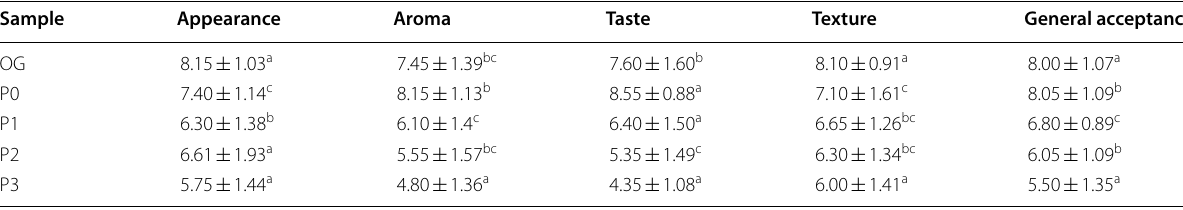
Values are mean of thirty panelists standard deviation ( n 30). Values with the different superscript within the same row are significantly different from each other ± = ( p 0.05) ≤ Keys: P0 Full fat milk 30%, peanut 25%, soybean oil 15%, sugar 28%, mineral mix 2%, P1 Orange-fleshed sweet potato 26.5%, sorghum 26.5%, full fat milk 30%, = = soybean oil 5%, sugar 10%, moringa leaves 2%); P2 Soycake 15%, Orange fleshed sweet potato 26.5%, sorghum 26.5%, full fat milk 15%, soybean oil 5%, sugar 10%, = moringa leaves 2%;